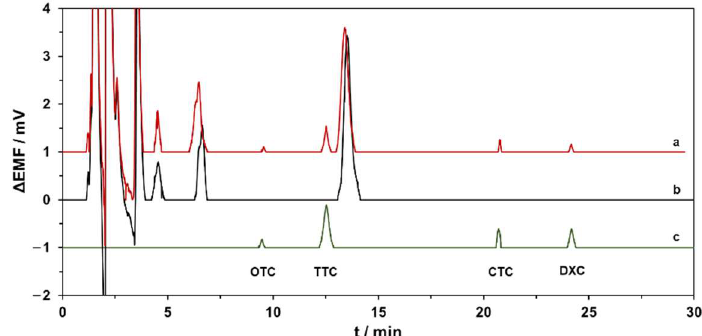
Figure 2. Chromatograms obtained with the proposed HPLC-ISE method after the injection of ( a ) extract of fresh semi-skimmed milk spiked at 100 µ g L − 1 (MRL level); ( b ) extract of blank fresh semi-skimmed milk; ( c ) standard solution of TCs at 3.0 × 10 − 7 M ( ≈ 140 µ g L − 1 ).